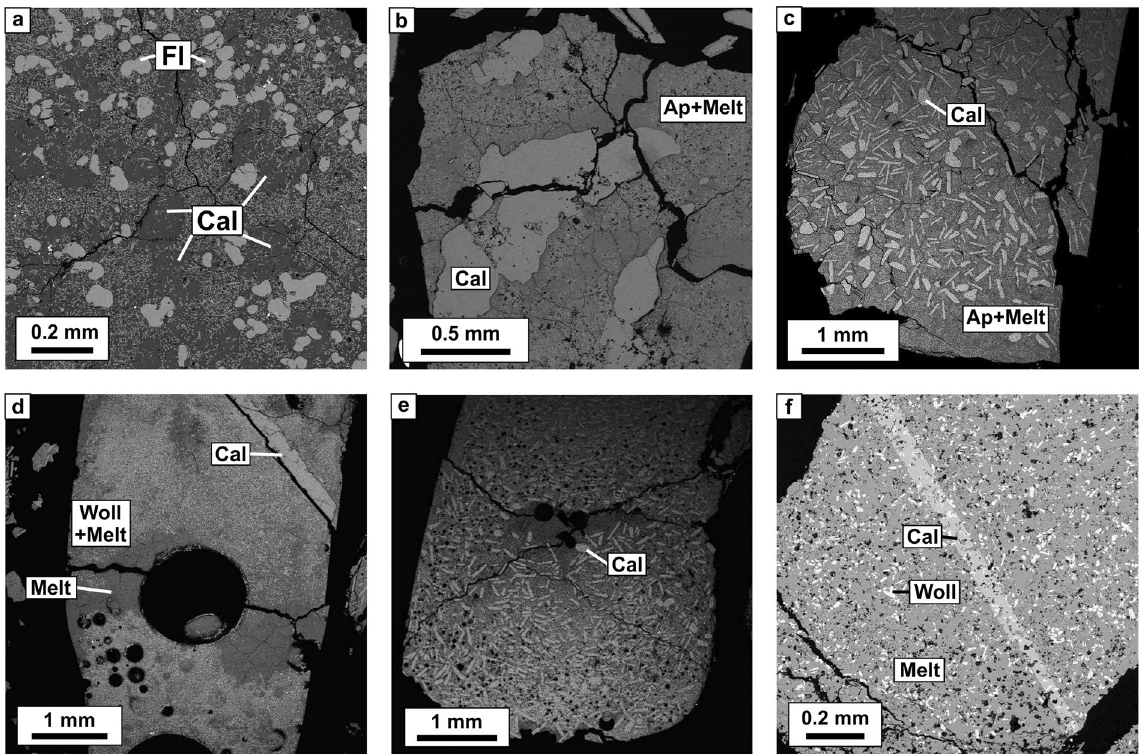
Figure 1. Morphology of calcites formed in experiments: ( a ) #3 NCFP-9; ( b ) #4 NCP-1; ( c ) #6 NCP-1; ( d ) #7 NCPSi-1; ( e ) #8 NCPS-1; ( f ) #10